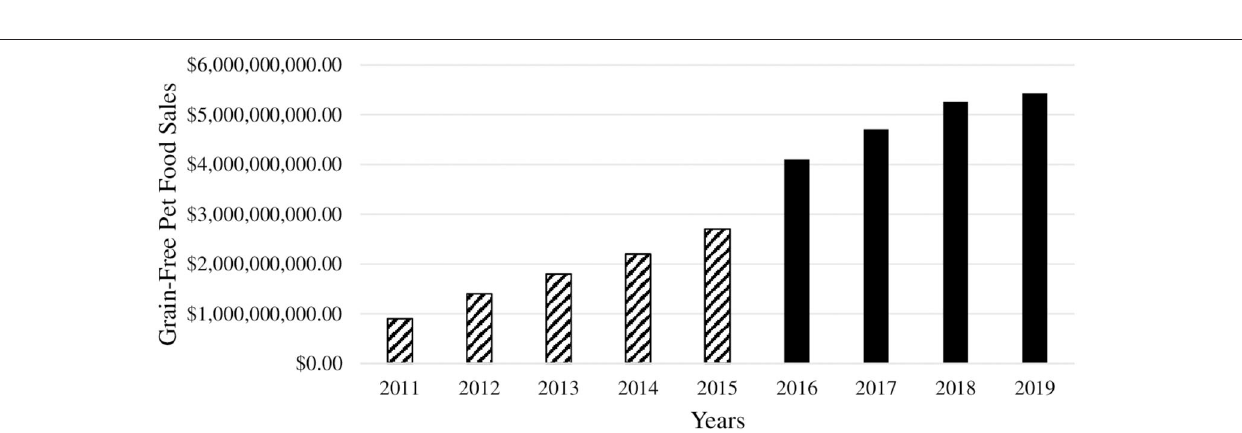
FIGURE 4 | Age distribution of patients with dilated cardiomyopathy (DCM), all cardiology patients, and all patients from Red Bank Veterinary Hospital (Tinton Falls) from 2005 to 2020. Triangles depict the average age of patients at the time of DCM diagnoses. Squares depict the average age of patients with other cardiovascular diagnoses. Circles depict the average age of patients for non-cardiac services.